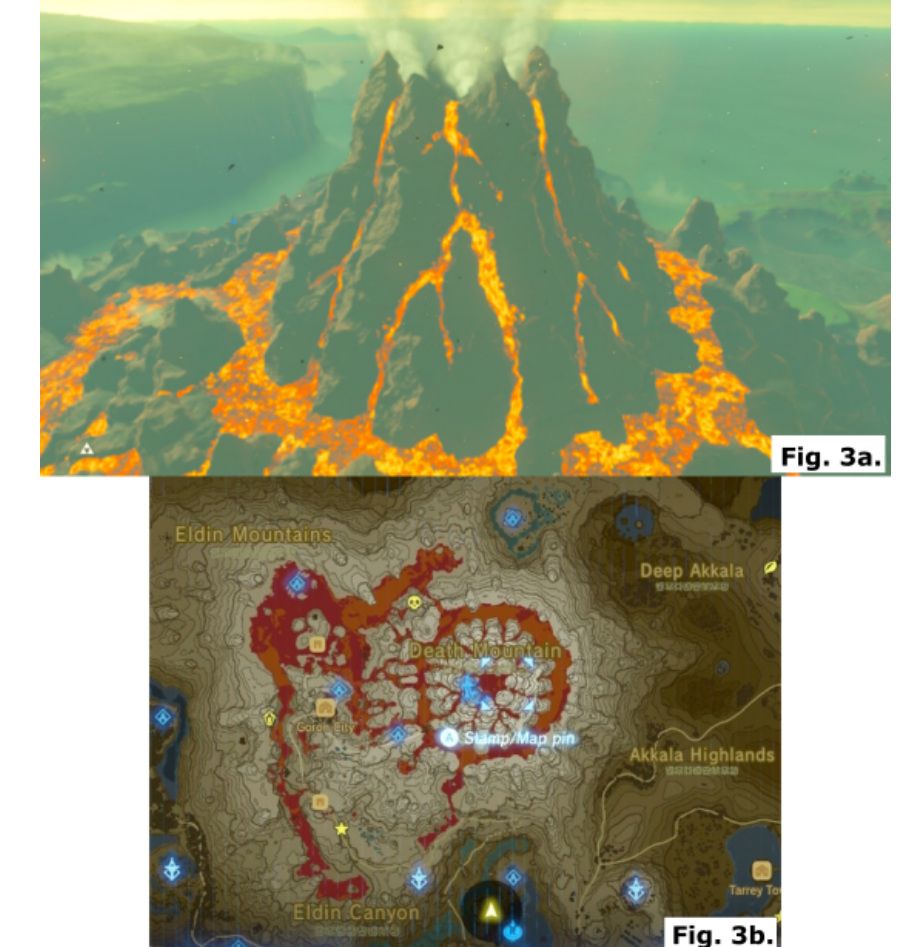
Figure 3. The two-tiered caldera of Death Mountain in The Legend of Zelda: Breath of the Wild © Nintendo